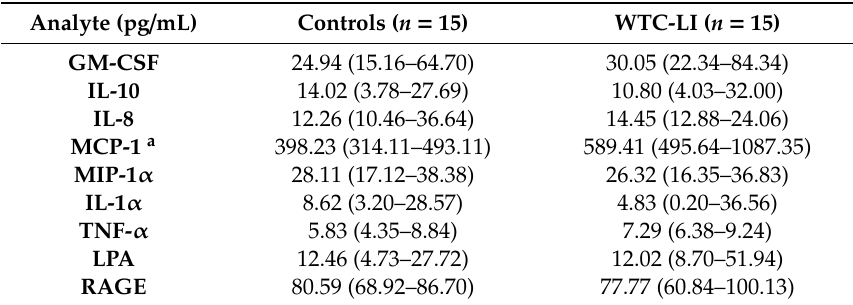
Table 3. Analytes available in the metabolomics